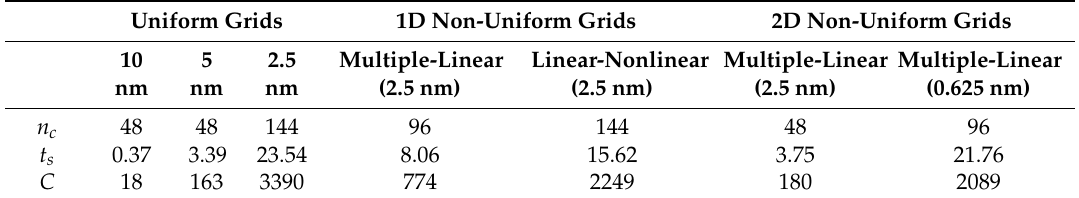
Table 2. Number of parallel-computing cores n c , total hours of simulation t s , and computational cost C for the cases of uniform grids, 1D non-uniform grids, and 2D non-uniform grids. Uniform Grids 1D non-uniform Grids 2D Non-Uniform Grids